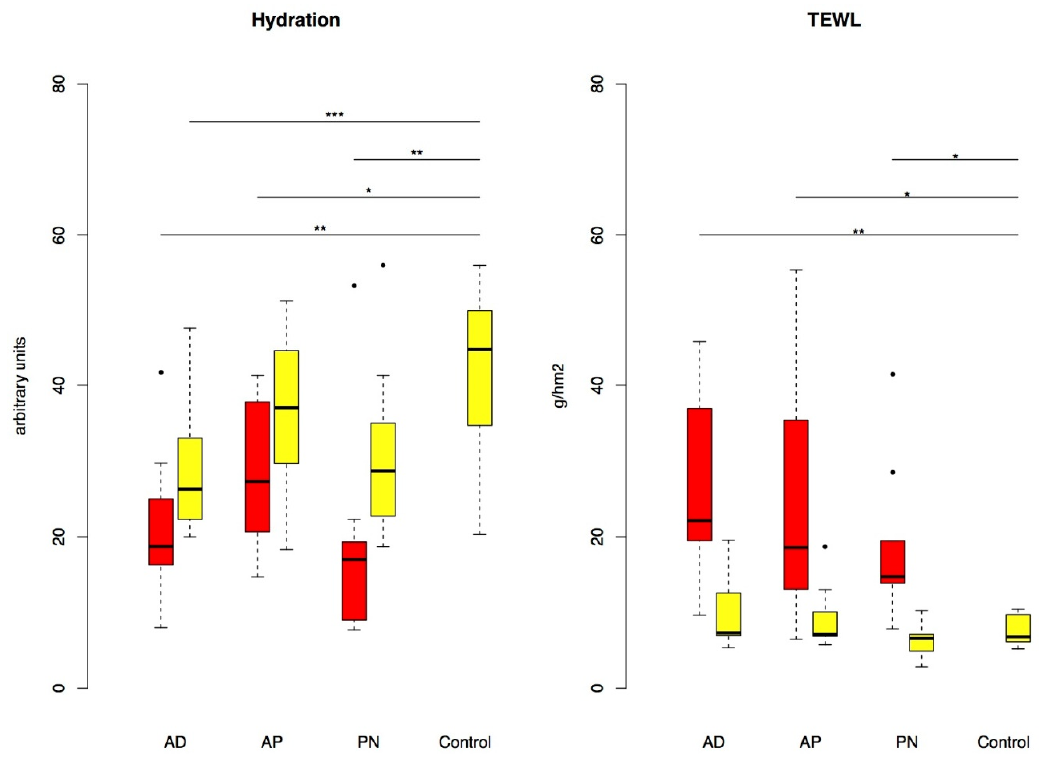
Figure 2. Hydration and TEWL in lesional (red) and non-lesional (yellow) skin (boxplots with outliers given as single dots). p -value: * p < 0.05, ** p < 0.01, *** p < 0.001. TEWL: transepidermal water loss; AD: classic atopic dermatitis; AP: atopic prurigo; PN: non-atopic prurigo nodularis.